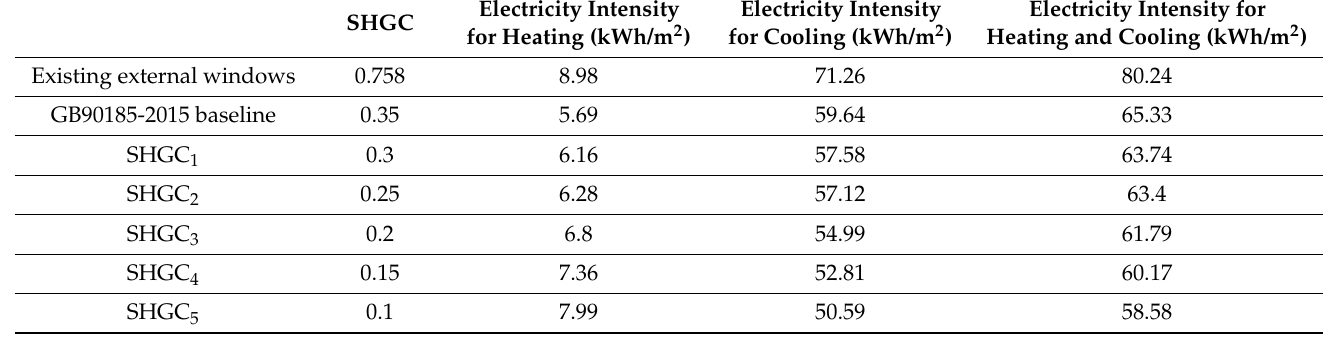
Table 10. Energy simulation results of using different SHGC values for window energy retrofitting.